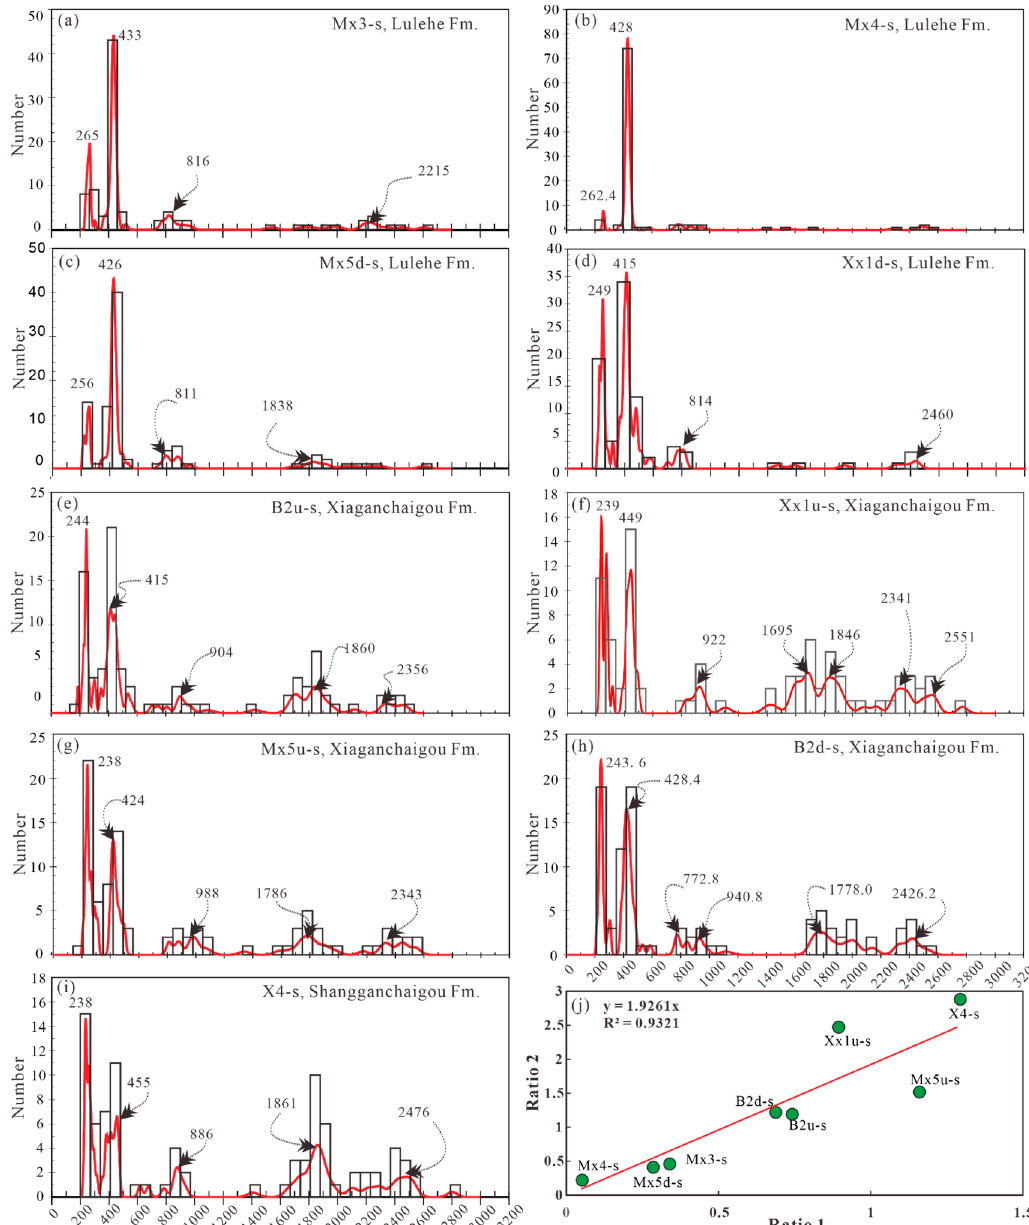
Figure 6. ( a – i ) Graphs of detrital zircon age spectra in study area. ( j ) Peaks height correlation between the Precambrian zircons and late Paleozoic to Mesozoic zircons. The ratio 1 represents “late Paleozoic to Mesozoic/early to middle Paleozoic zircons” ratio, and ratio 2 represents the “Precambrian zircons/early to middle Paleozoic zircons” ratio.